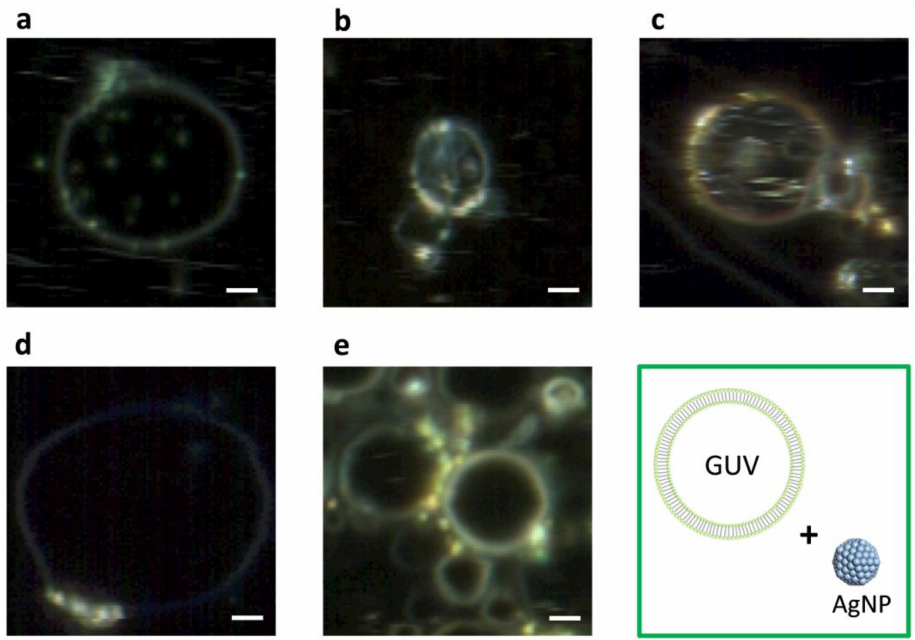
Figure 7. DFM images of GUV+AgNPs where GUVs are of varied composition including ( a ) DMPC only, ( b ) 10 mol%, ( c ) 20 mol%, ( d ) 30 mol%, and ( e ) 40 mol% CHOL:DMPC, respectively. Scale bars are 5 µ